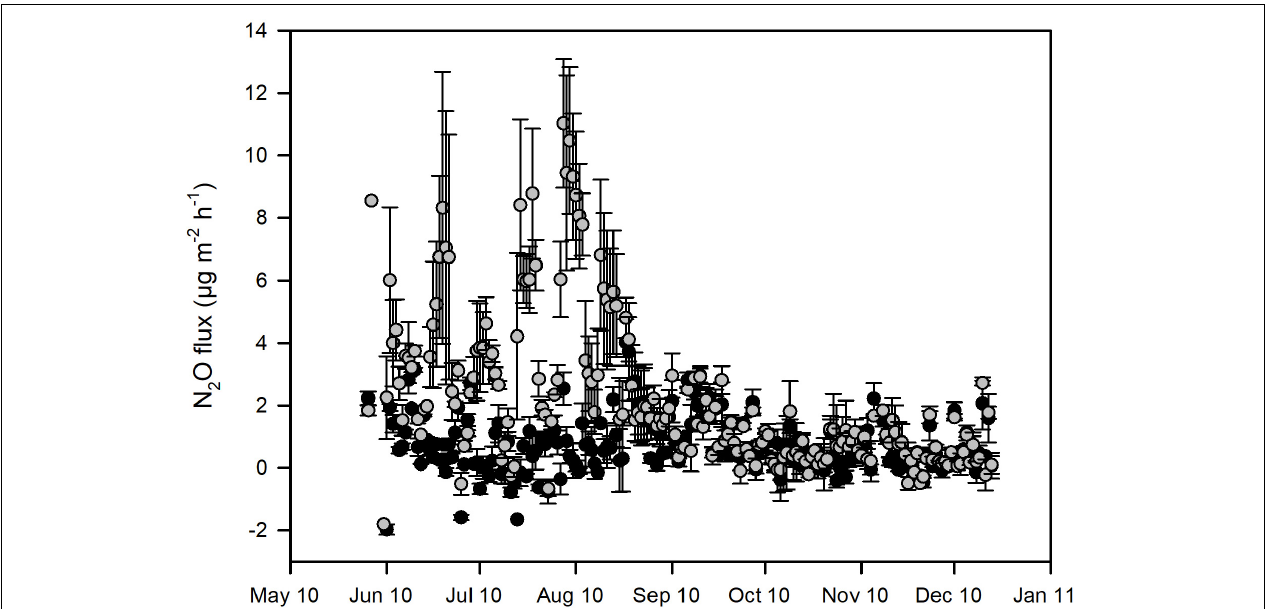
FIGURE 2 | Detail of the soil N 2 O emissions from a Norway spruce forest at Flakaliden measured with automatic chambers at daily resolution during the summer and fall 2010, from non-fertilized control (black symbols) and fertilized plots (gray symbols).